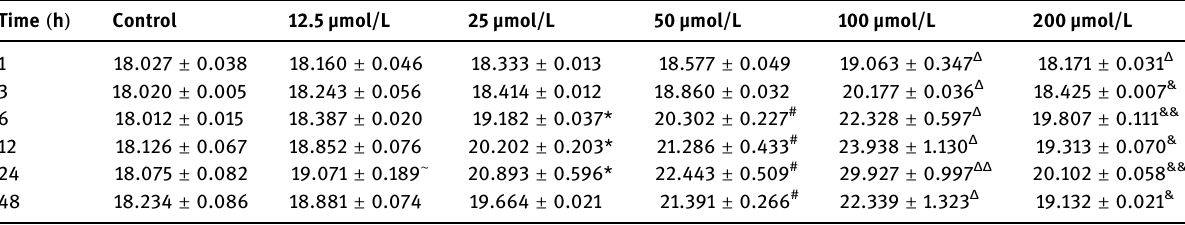
Table 2: The release of H 2 S from P - A Time ( h )